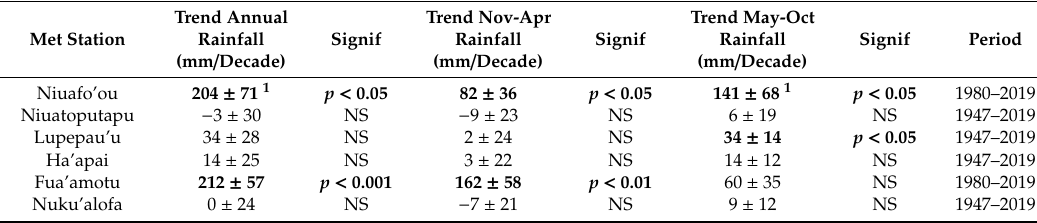
Table 5. Historic linear regression trends in annual and seasonal rainfalls with standard errors and significance level (Signif) for the meteorological stations in Table 4. Long- and short-term records are compared over the same periods, i.e., 1947–2019 and 1980 to 2019, respectively. Bold values are statistically significant.